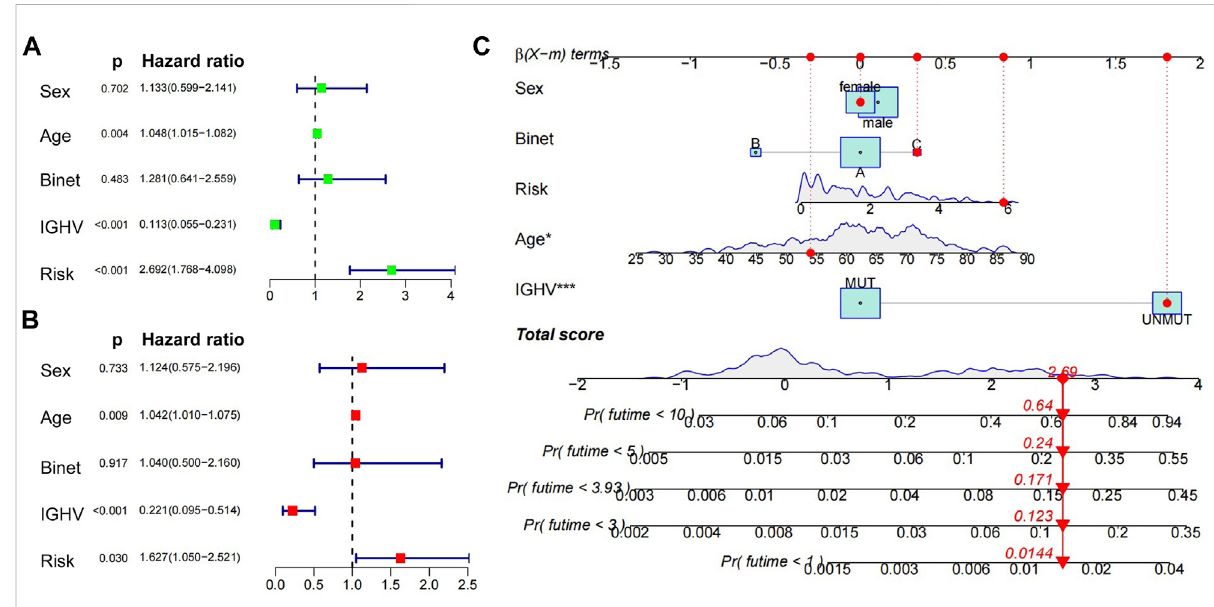
FIGURE 7 Univariate, multivariate Cox regression analyses and construction of nomograms. (A) (B) Univariate and multivariate Cox regression analyses of clinical traits (age, sex, IGHV mutated status, Binet) and nine-gene risk score. (C) Nomogram predicting the probability of 1-, 3-, 5-, and 10-year overall survival rates of ICGC-CLL patients. Add the points from these 5 variables together to fi nd the location of the total points. The total points projected on the bottom scales indicate the probability of 1-, 3-, 5-, and 10-year overall